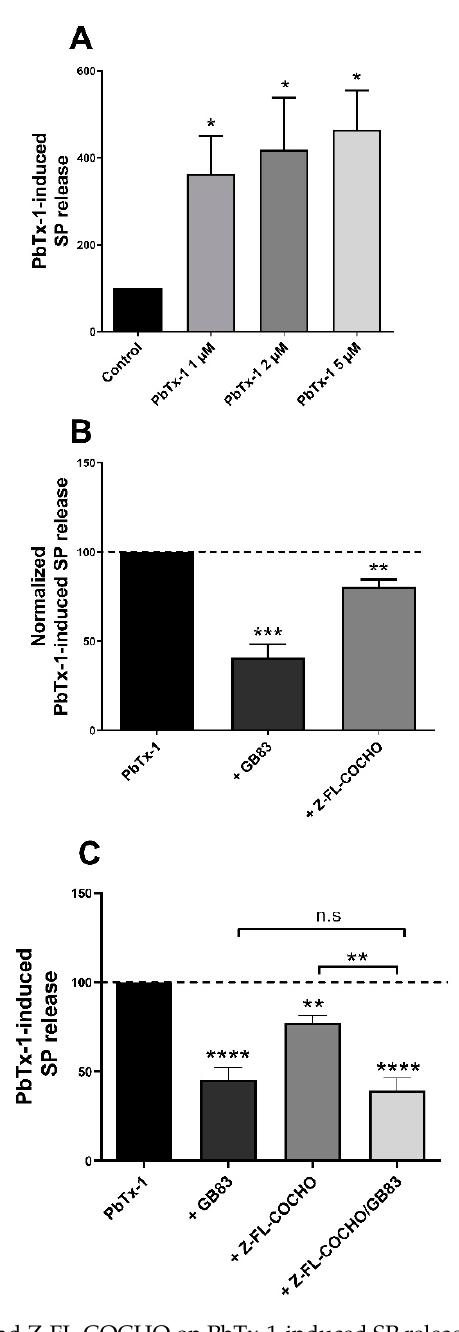
Figure 3. Effects of GB83 and Z-FL-COCHO on PbTx-1-induced SP release from co-cultured sensory neurons and keratinocytes. ( A ) Co-cultures were treated for 90 min with PbTx-1 1 µM (n = 4), 2 µM (n = 6) and 5 µM (n = 5). Data were normalized according to the control condition (100%) and expressed as the mean ± SEM and statistically analyzed with one-tailed paired t-test between PbTx-1 condition versus control. * p < 0.05. ( B ) GB83 and Z-FL-COCHO were pre-incubated 10 min before 1 µM PbTx-1 for 90 min. Normalized data were expressed as the mean ± SEM of 7 experiments and analyzed using a one-way ANOVA followed by a Dunnet post-test for multiple comparisons to control. ** p < 0.01 and *** p < 0.001. ( C ) GB83, Z-FL-COCHO or the combination GB83/Z-FL-COCHO were pre-incubated 10 min before 1 µM PbTx-1 for 90 min. Data were expressed as the mean ± SEM of four experiments and statistically analyzed using an one-way ANOVA followed by a Holm–Sidak test for multiple comparisons to control and between condition (GB83/Z-FL-COCHO was compared to GB83 alone and to Z-FL-COCHO alone). ** p < 0.01, *** p < 0.001 and **** p < 0.0001. ns: non-significant; PbTx-1: brevetoxin-1; SP: substance P.